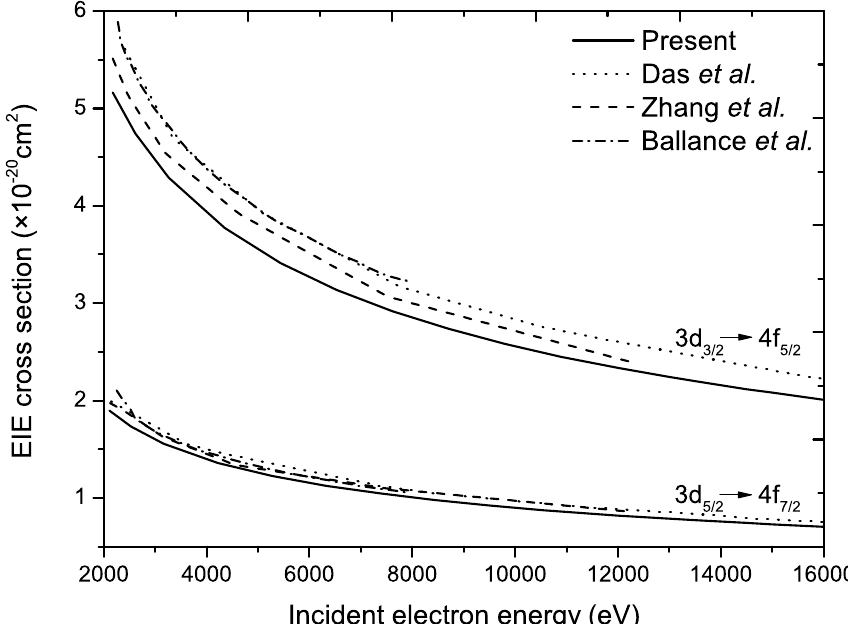
→ 4 f → 4 f and 3 d 5 / 2 7 / 2 3 / 2 5 /